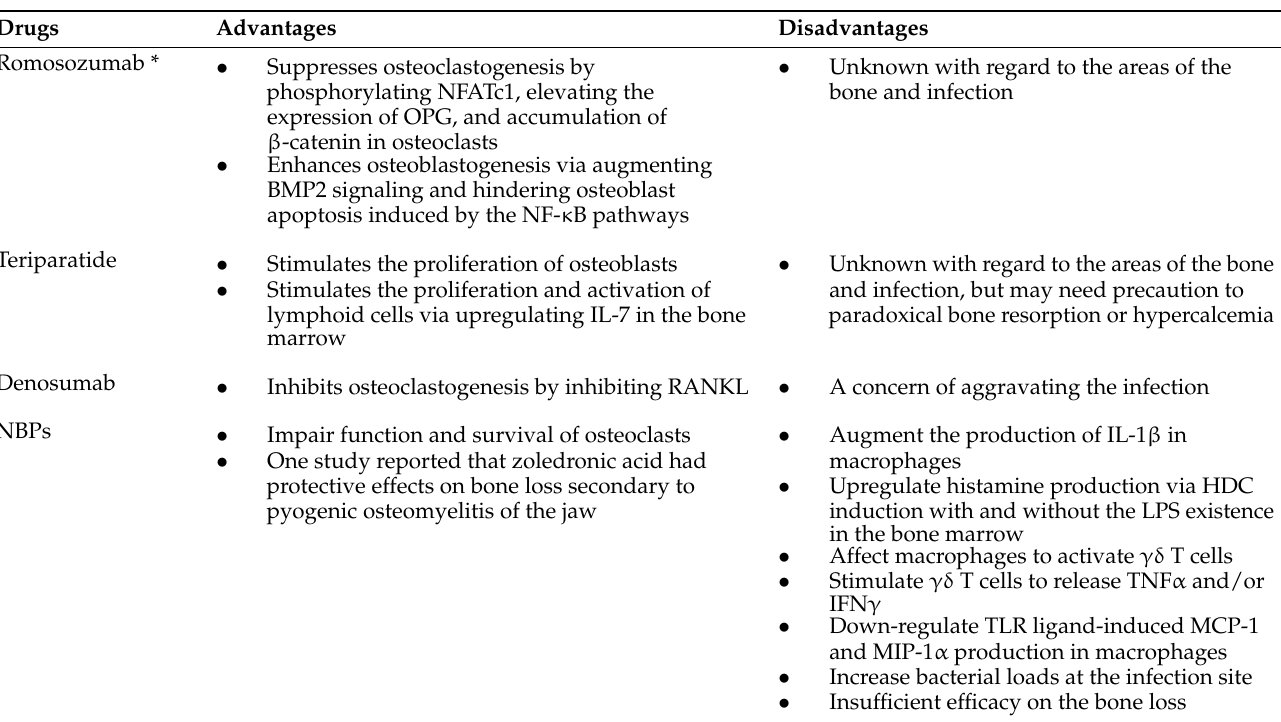
Table 1. Advantages and disadvantages of romosozumab, teriparatide, denosumab, and bisphosphonates (BPs) in the treatment for pyogenic osteomyelitis.